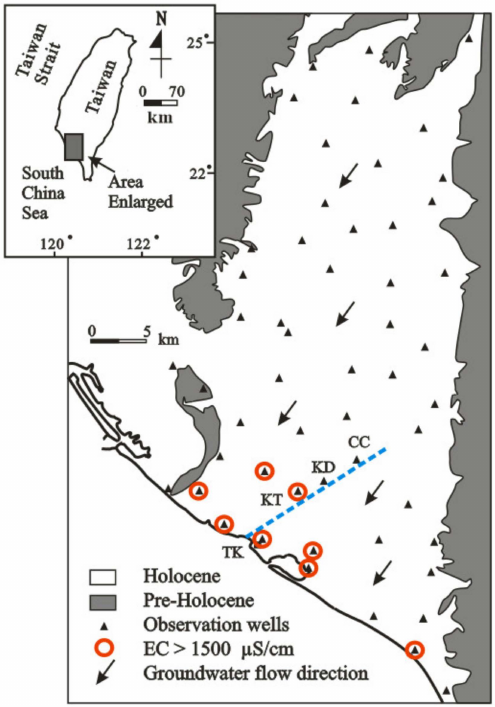
Figure 2. The locations of saline groundwater having an EC > 1500 µ S/cm (at 25 ◦ C), as well as observation wells within the Pingtung Plain, Taiwan. Hydrogeological profiles are marked with a blue dashed line (Please see Figure 3).